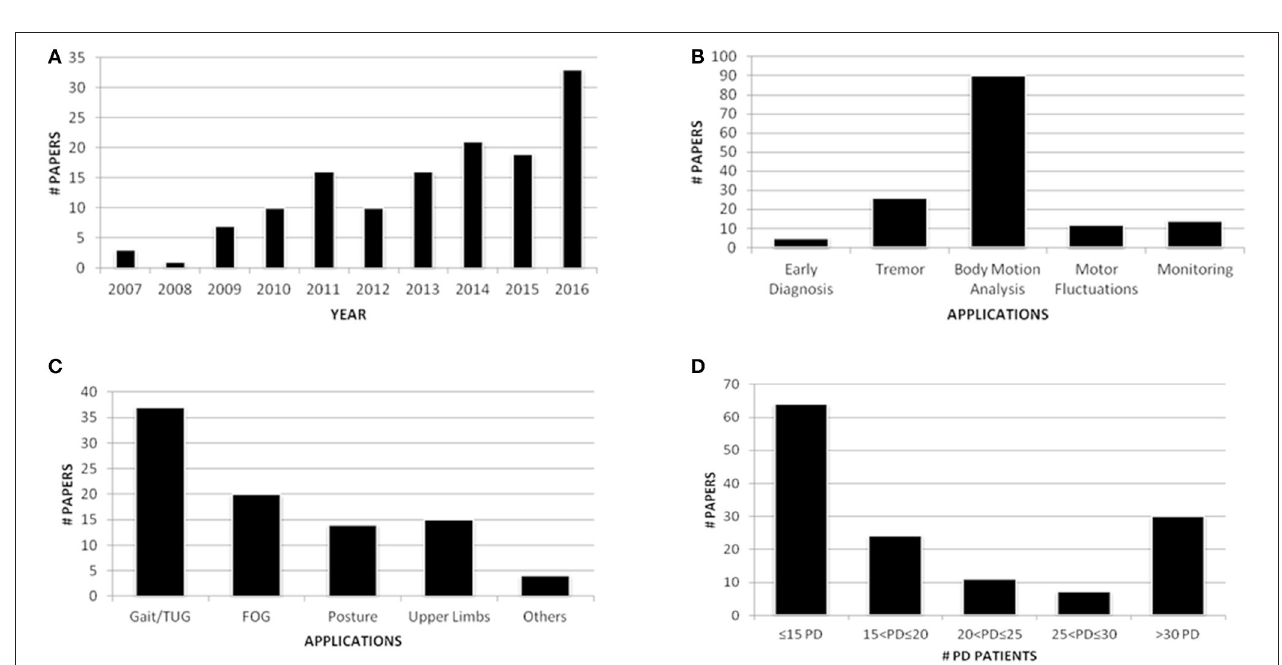
FIGURE 2 | Publication trend per year (A) ; paper distribution per application (B) ; papers within body motion analysis application (C) ; PD patients involved in the studies (D) .